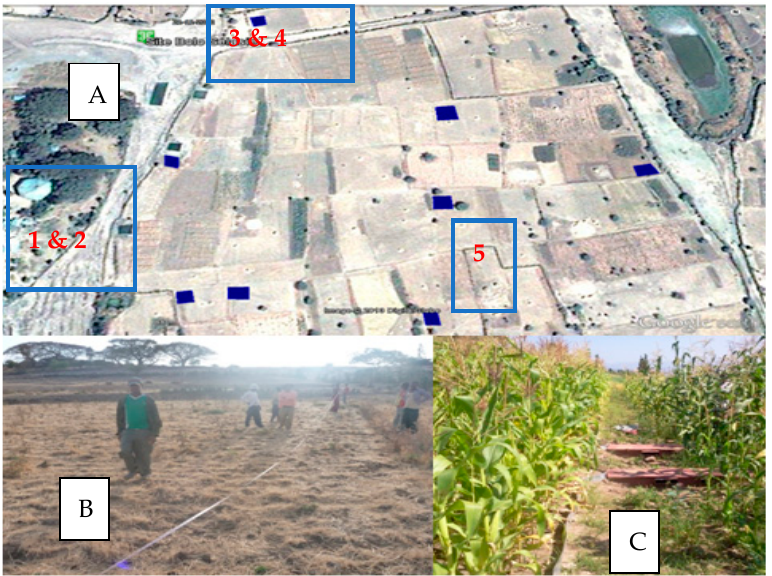
Figure 1. Google Earth photo showing trail site with five plots ( A ); field before the experiment ( B ); and trail plot with a runoff of troughs ( C ).